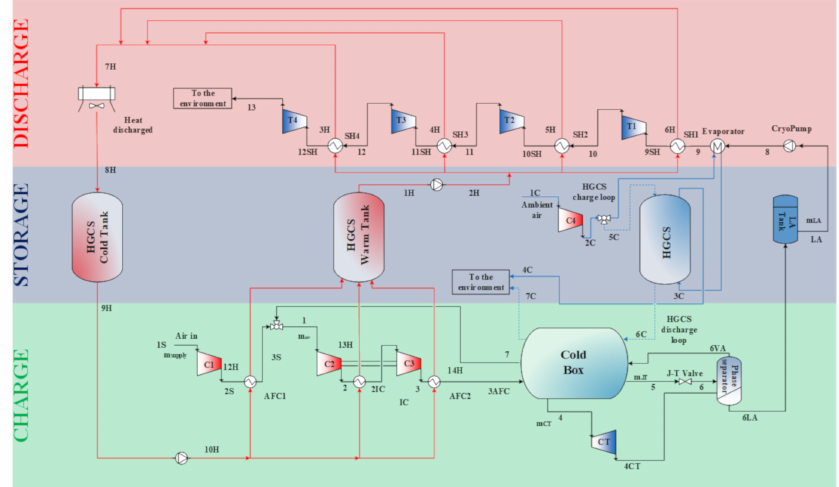
Figure 1. Process flow diagram of liquid air energy storage (LAES). Adapted from